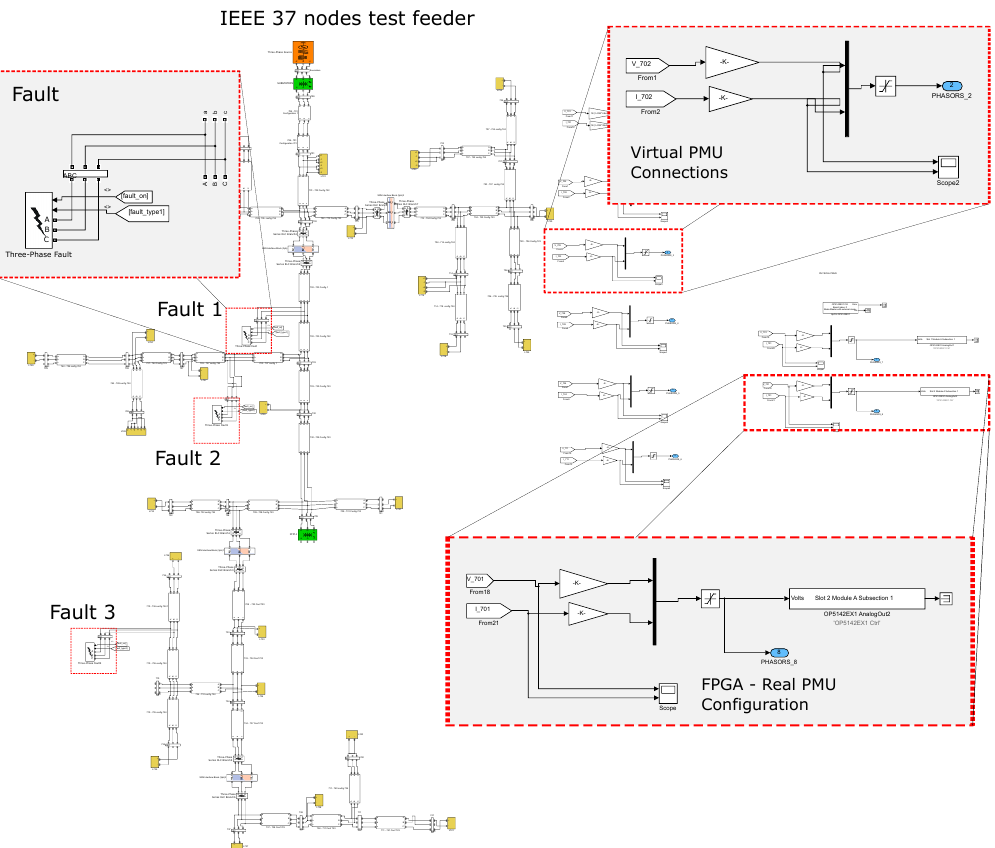
Figure 8. IEEE 37-nodes test feeder Opal-RT Model. The model is split into five subparts with the Opal-RT SSN solver configuration. Connectors for the virtual PMUs and the FPGA analog outputs are on the right side.